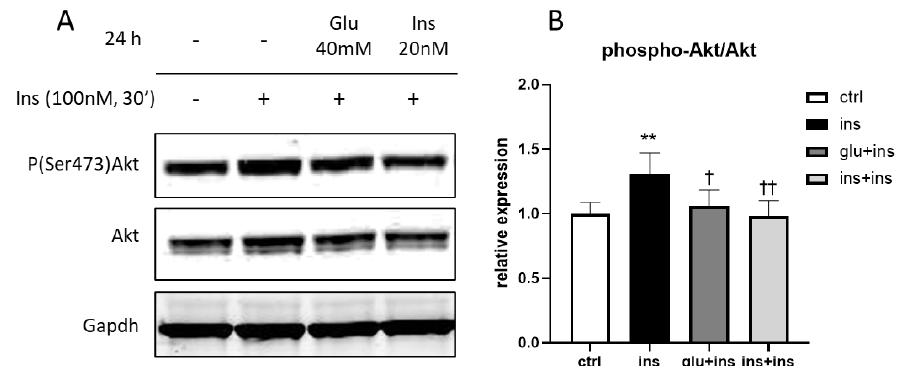
chronic treatment with high-concentration insulin, thus showing that insulin resistance was successfully achieved (Figure 3).